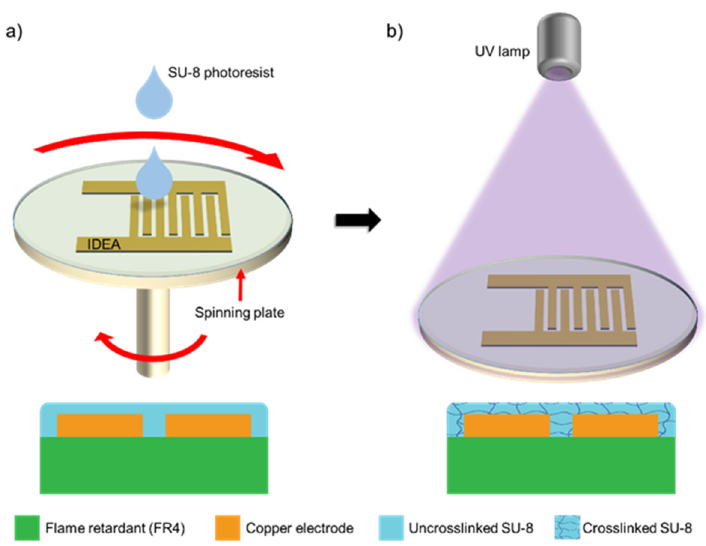
Figure 3. SU-8 deposition process on the PCB: ( a ) spin-coating of PCB with uncrosslinked SU-8 mixed with solvents to a thickness of 2 µm and ( b ) UV exposure of SU-8 for crosslinking after a soft-bake process to remove solvents.